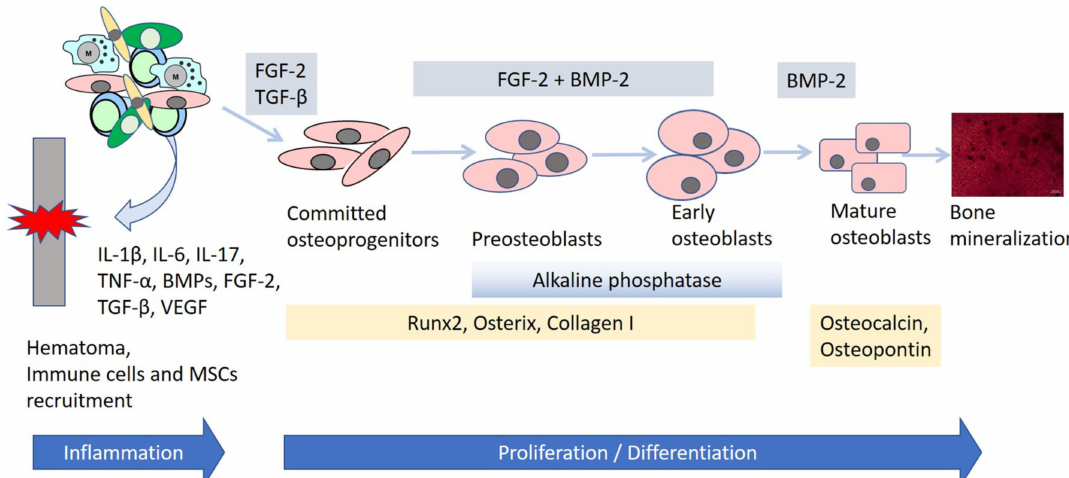
Figure 1. Schematic representation of the osteogenic differentiation of mesenchymal stem cells (MSCs) during bone regeneration. The first step of bone healing is the formation of fracture hematoma. The local hematoma attracts immune cells, creating an inflammatory microenvironment (IL-1 β , IL-6, IL-17, TNF- α ) and MSCs with an osteogenic and proangiogenic potential (TGF- β , BMPs, VEGF). Proliferation and osteogenic differentiation of MSCs is warranted by the simultaneous activity of FGF-2, TGF- β , and BMPs. BMPs increase the expression of osteogenic markers in MSCs, including the early osteogenic markers alkaline phosphatase, Runt-related transcription factor 2 (Runx2), osterix, and type I collagen, and the late markers osteopontin and osteocalcin. The bone mineralization image is taken from the authors’ own collection of the osteogenic differentiation of MSCs (Alizarin Red